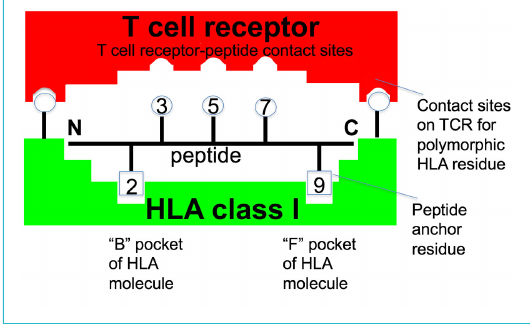
Figure 1: The idealized tripartite interaction of the human leuko- cyte antigen (HLA)-molecule, the peptide, and the T cell receptor (TCR). Two amino acid side chains of the peptide, the second and the ninth fit into pockets in the HLA molecule, tightly anchoring it to form a peptide-HLA complex. The peptide-HLA complex is recog- nized by the T cell TCR through specific polymorphic contact sites on both the peptide, and on the HLA